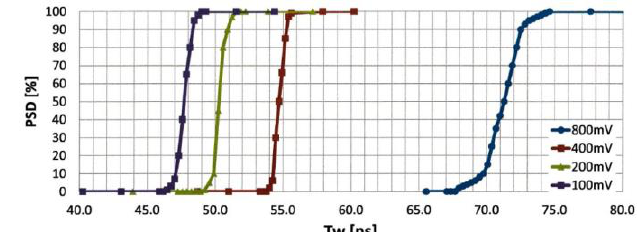
Fig. 9. Percentage of "slow" classification for different pulses widths using time duration and pulse height discrimination topology.